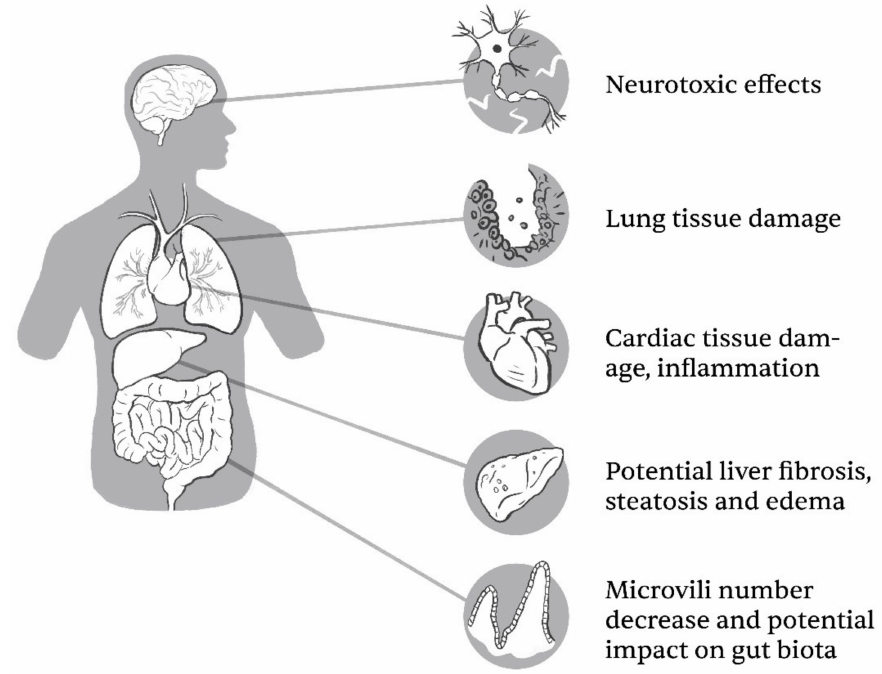
Figure 2. TiO 2 NPs can potentially cause adverse effects on a cellular level in a variety of organ systems within the human body. Apart from nervous, respiratory, cardiovascular and digestive systems, there is some report of toxicity towards the skin and of potential impacts on embryonal development (Illustrator: Matevž